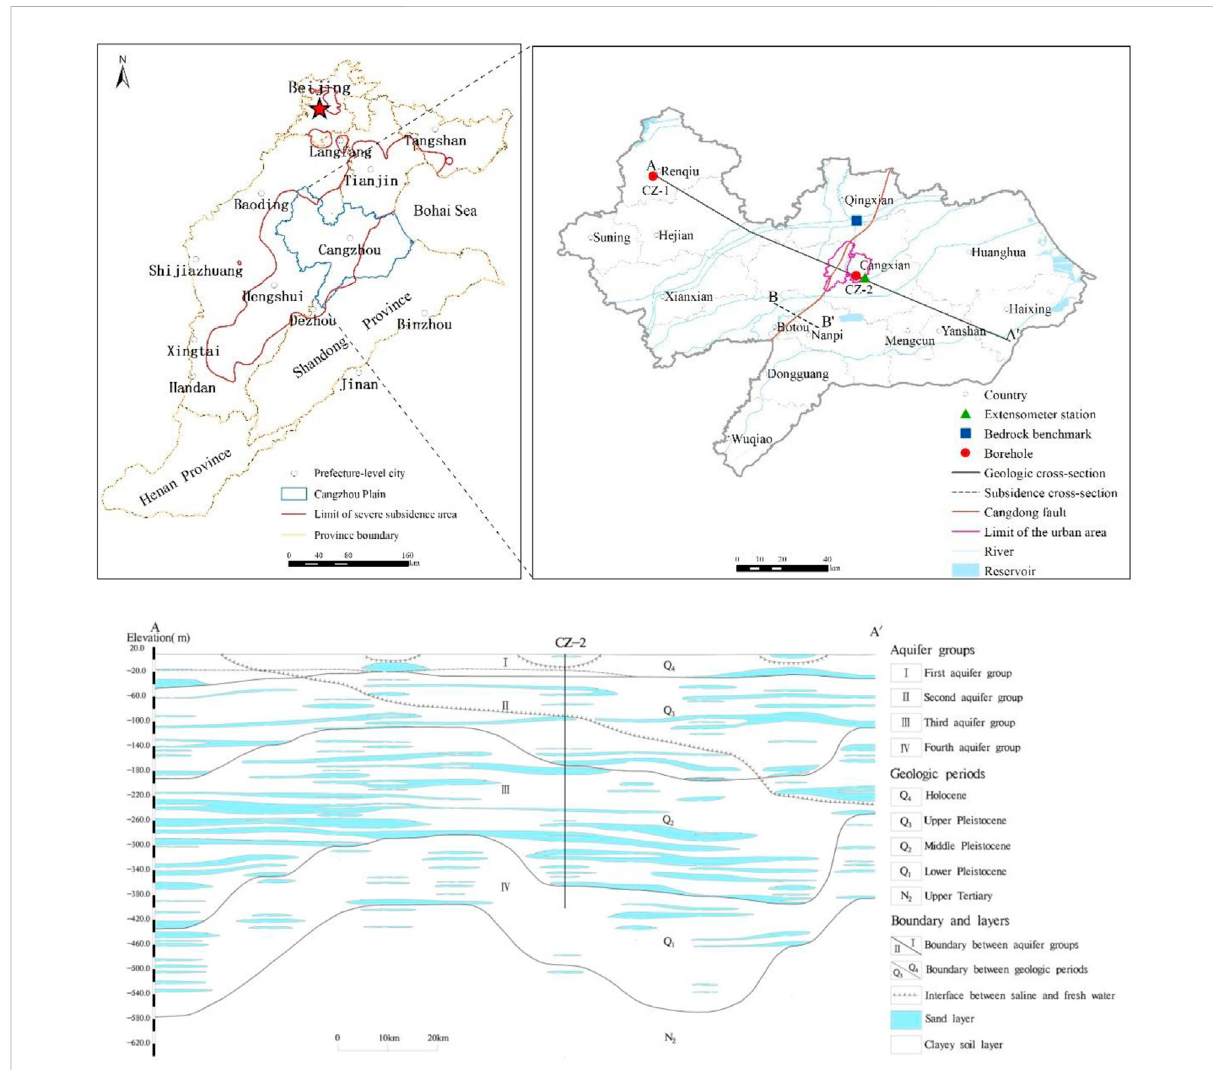
FIGURE 1 Sketch map of the North China Plain and the Cangzhou Plain showing distribution of the major land subsidence areas, and a hydrogeological cross section A-A ′